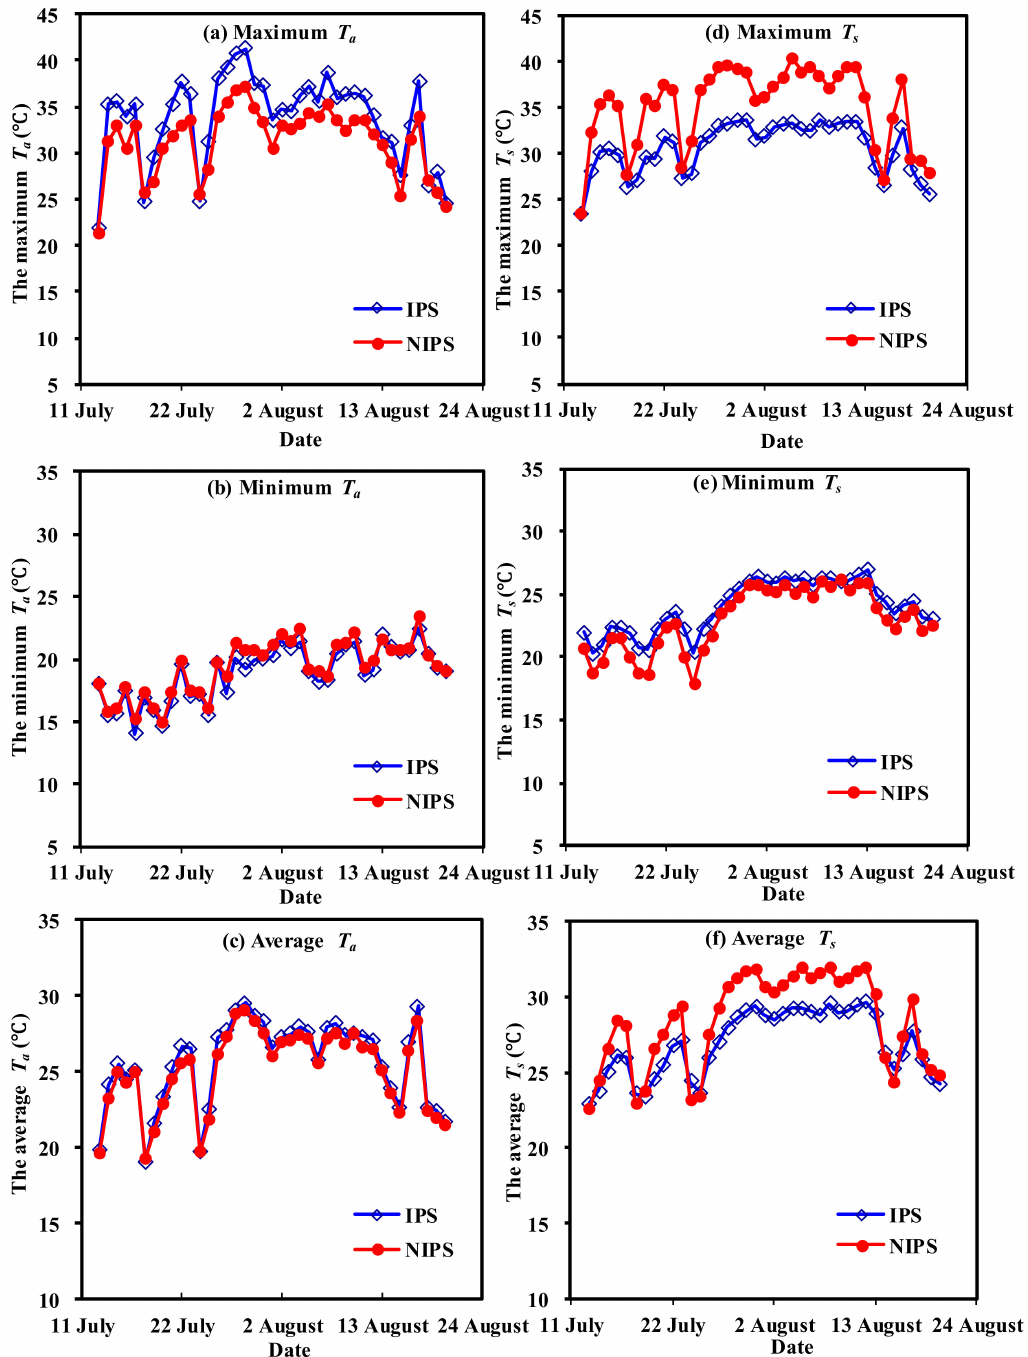
Figure 4. Effects of IPS on air temperature T a ( a ) maximum T a , ( b ) minimum T a , ( c ) average T a and soil temperature T s ( d ) maximum T s , ( e ) minimum T s , ( f ) average T s during C2 of